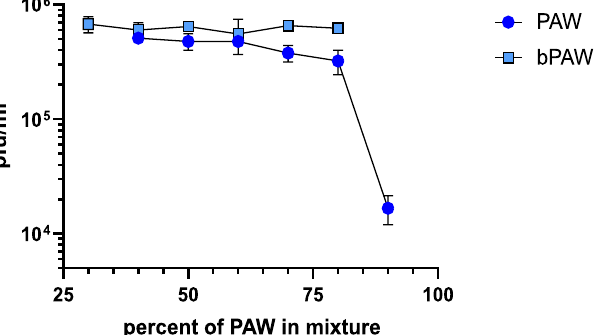
Figure 2. Effect of PAW concentration on SARS-CoV-2 infectivity. A fixed amount of virus was incubated for 30 min with dilutions of PAW in distilled water or in PBS. The virus mixtures were then titrated by plaque assay. The data was used for non-linear curve fitting (inset) to estimate the concentration of PAW that reduces by half the virus titer. Percentages refer to the final concentration of PAW in the mixtures that were titrated in cell cultures. Generated with INKSCAPE 1.1 (www. inksc ape.